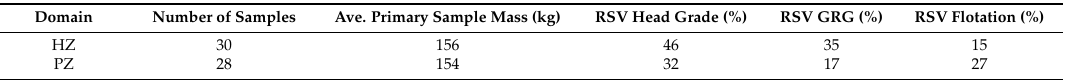
Table 18. RSV values for underground sampling and testwork programme.